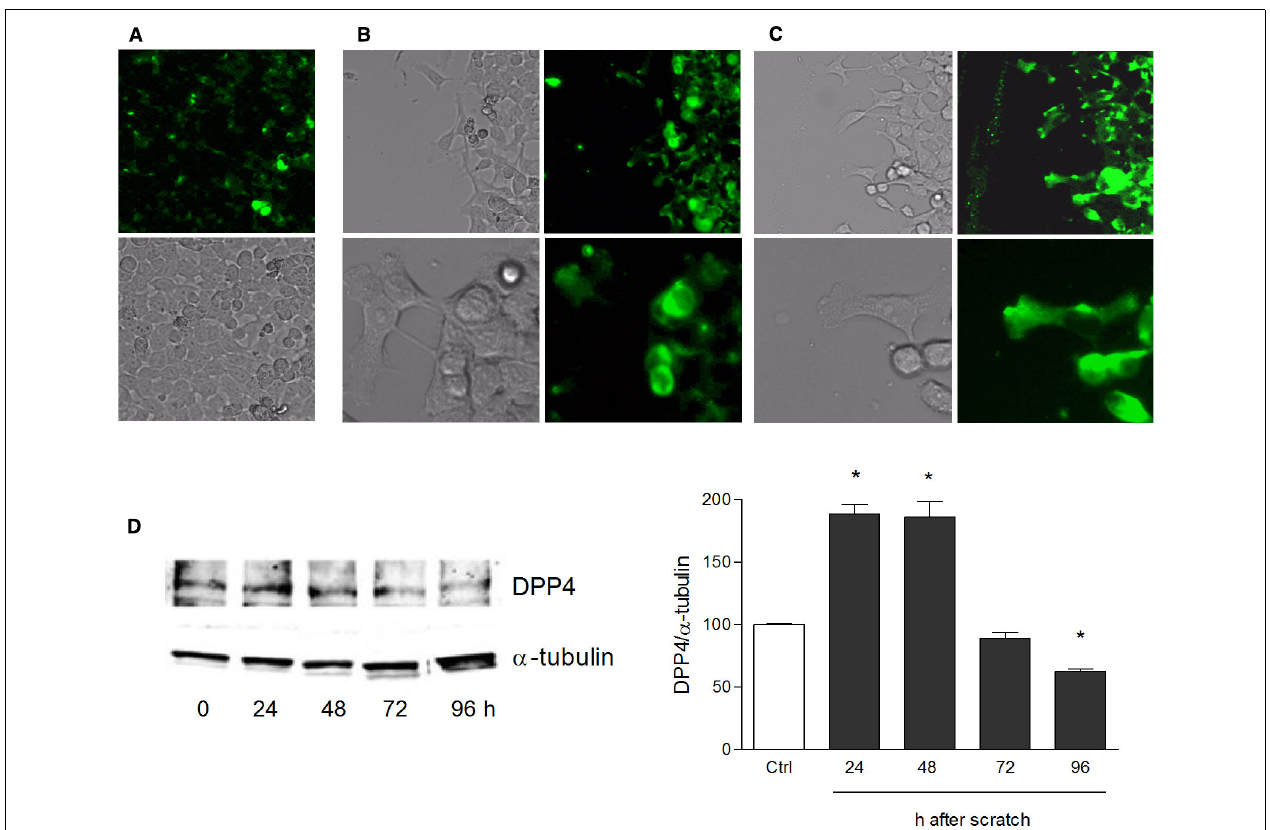
FIGURE 1 | Increase of DPP4 expression in NCTC 2544 keratinocytes subjected to scratch wound. DPP4 expression is analyzed under basal conditions (A) and following scratch wound (B,C) . Expression of the enzyme appears upregulated already 8 h after scratch (B) as shown by immunostaining and its overexpression is maintained up to 48 h (C) . In (A) immunostaining for DPP4 (upper panel) and a bright field image (lower panel) of a NCTC2544